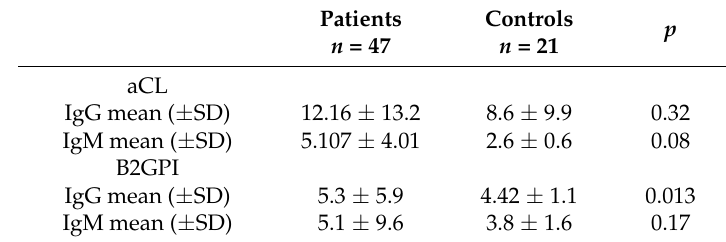
Table 3. Distribution of aPL between group I with hypertension (cases) and group II controls.